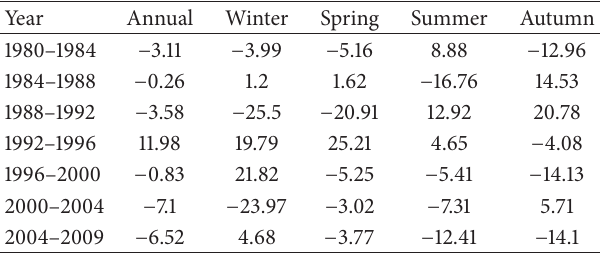
Table 5: 5-year trends of wind power for the year and